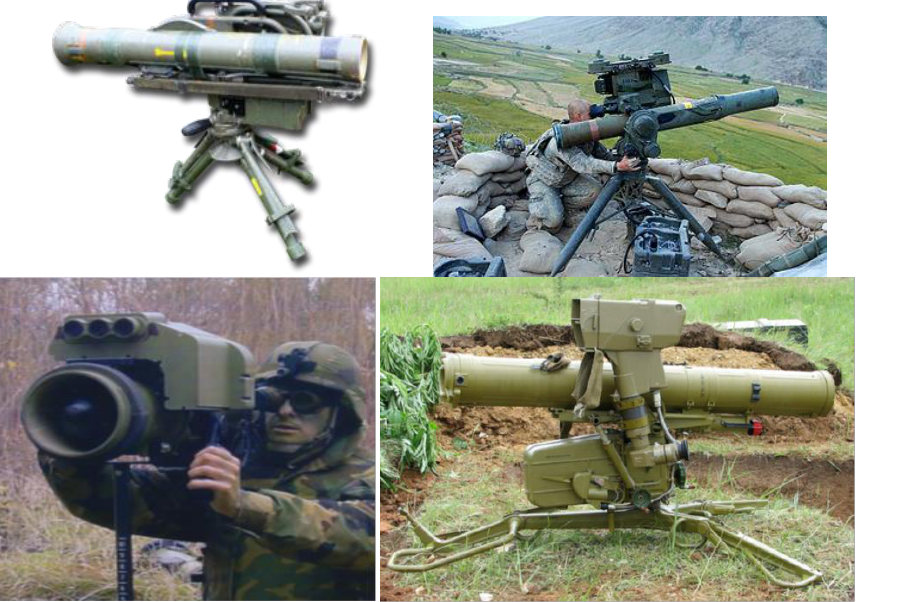
Figure 2 – Second generation ATGMs: MILAN, BGM-71 TOW (upper section); 9K111 „FAGOT“ and „BUMBAR“(lower